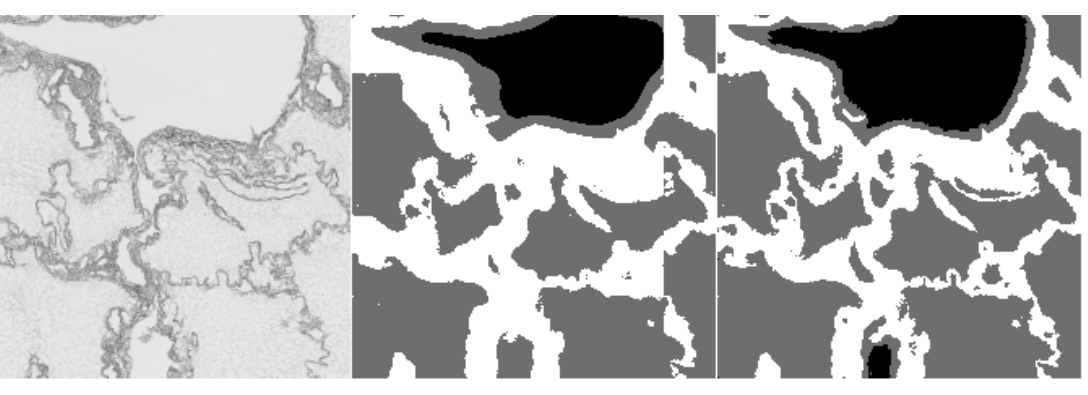
Figure 7. Example of semantic segmentation, where the neural network reached better results. The original image (on the left ), the result from the HCTFS (in the middle ), and the results from the neural network (on the right